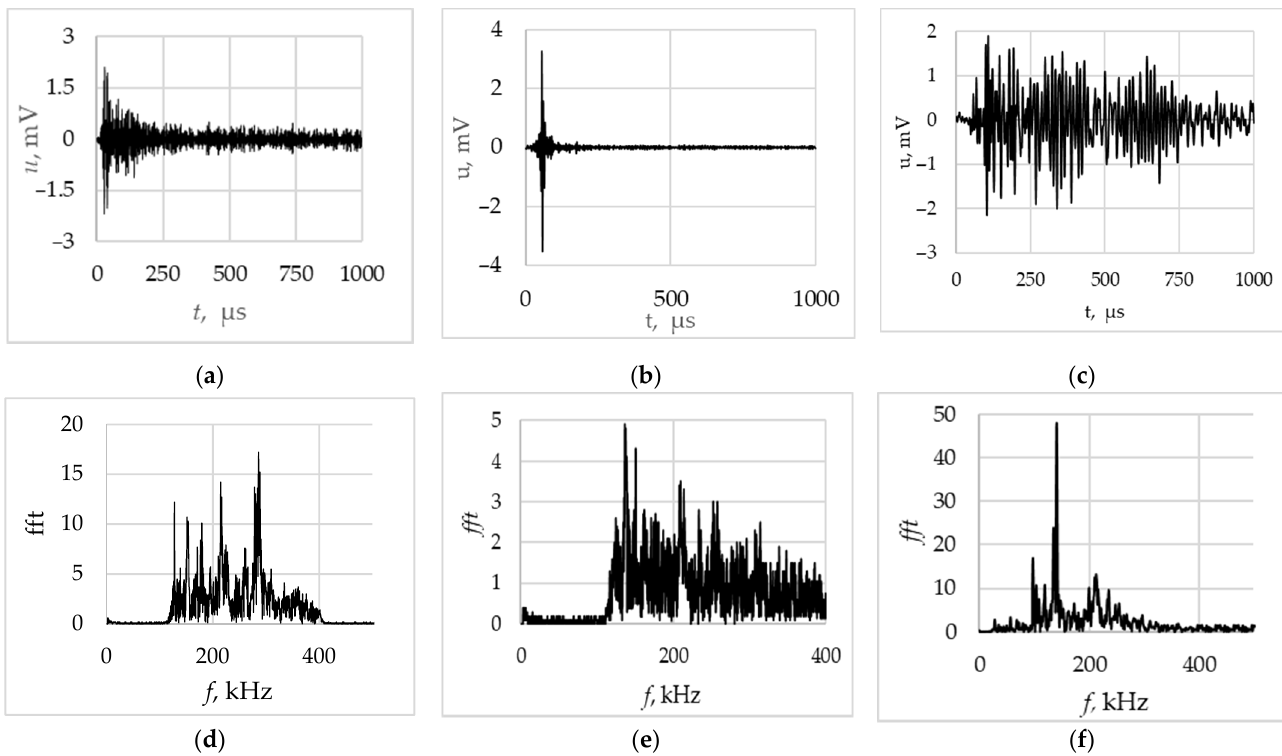
Figure 10. Typical AE signal waveforms and spectrums for defect-free weld joint ( a , d ), for weld joint with diffusion interlayers ( b , e ) for weld joint with lack of penetration ( c , f ).